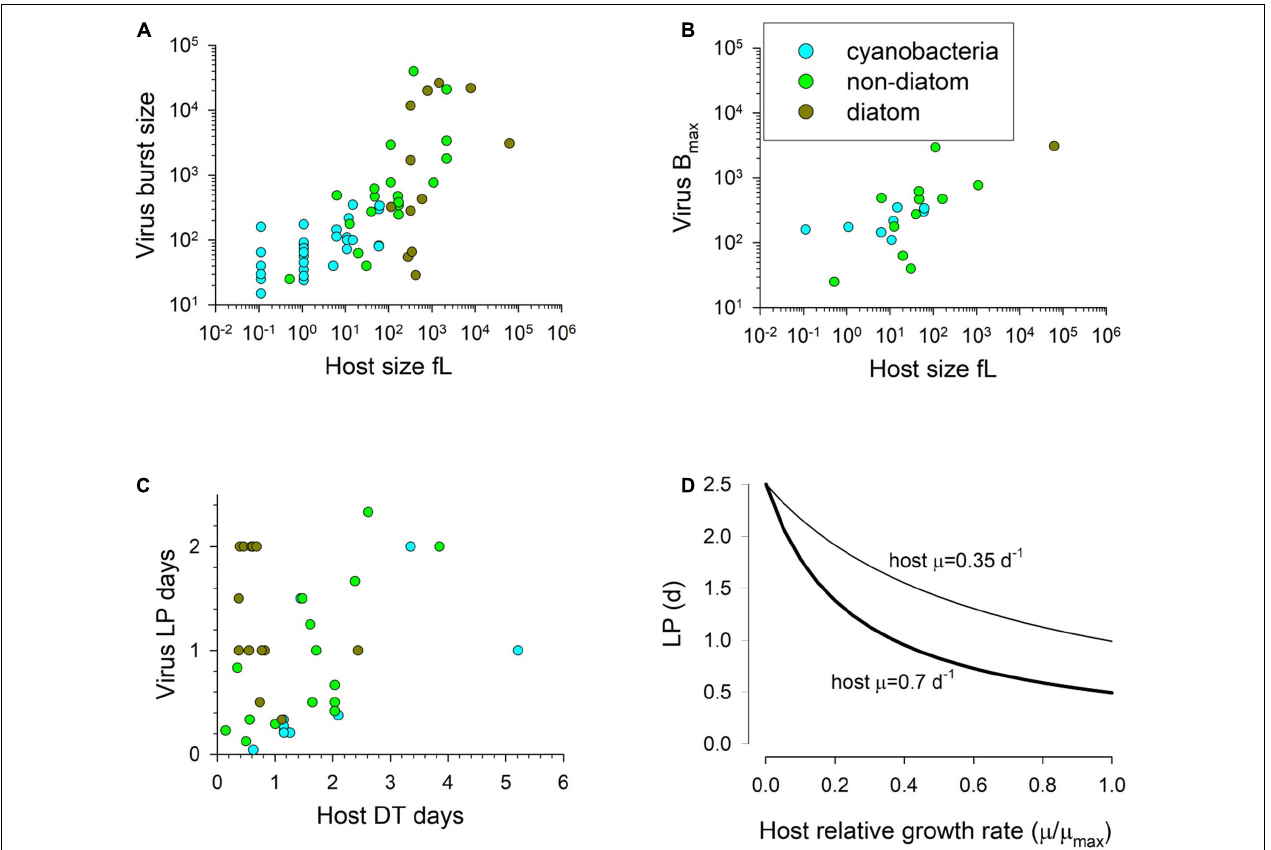
FIGURE 3 | Panels (A) and (B) show the burst size vs host cell volume; panel (A) has an all- data relationship of R 2 = 0.54, y = 56.56x 0 . 4647 , while panel (B) shows the maximum burst size per species with an all-data relationship of R 2 = 0.47, y = 86.6x 0 . 4753 . Panel (C) shows the relationship between host doubling time and the latent period, while panel (D) shows the functional relationship between normalised host growth rate and latent period from Eq.11 for two different maximum host growth rates (0.35 and 0.7 d − 1 ) with LPmin normalised to the value of µ maxT ( LPDTmin ) as 0.5. LP = 2.5d at relative growth rate of 0. Source data from that collated by Edwards et al.